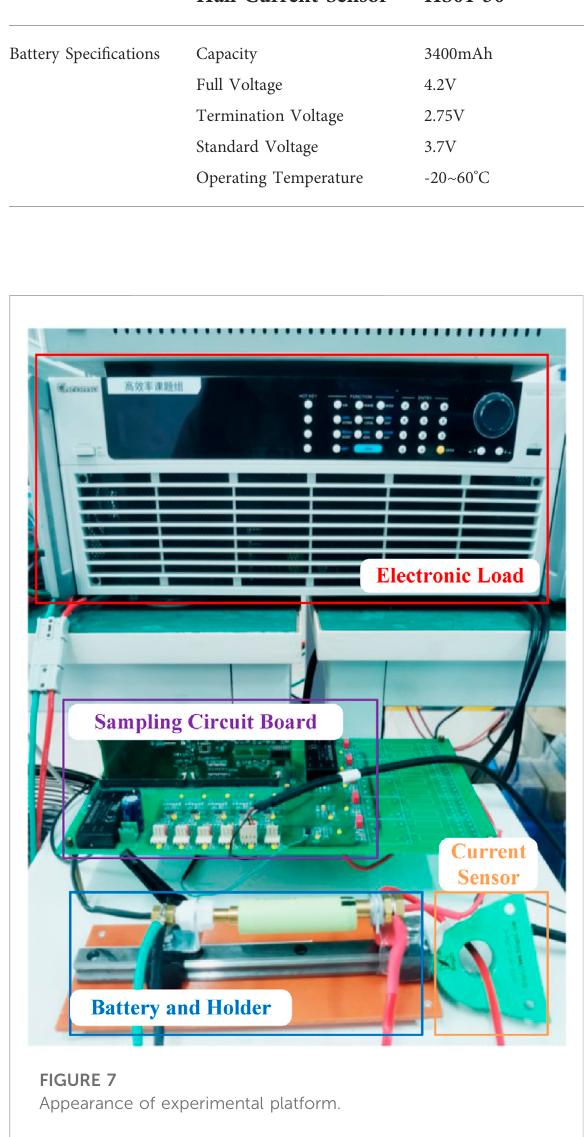
FIGURE 7 Appearance of experimental